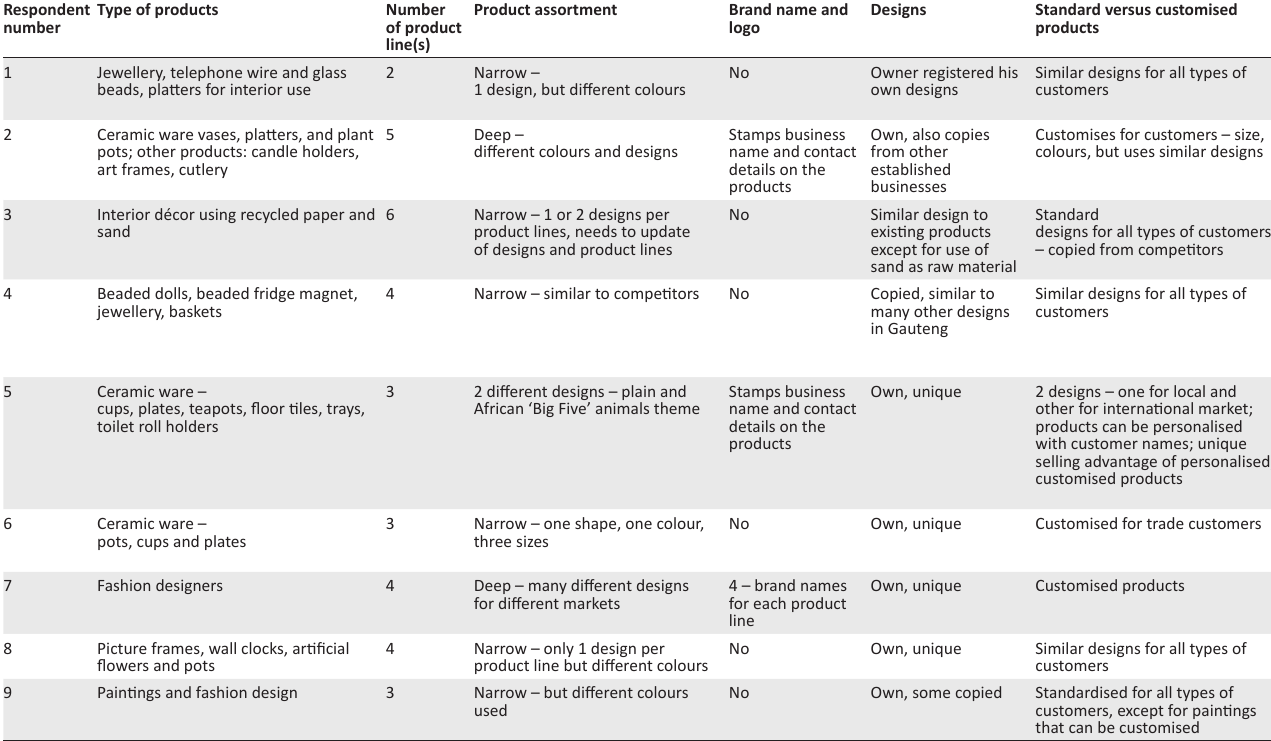
TABLE 2: Product strategies used by the craft business